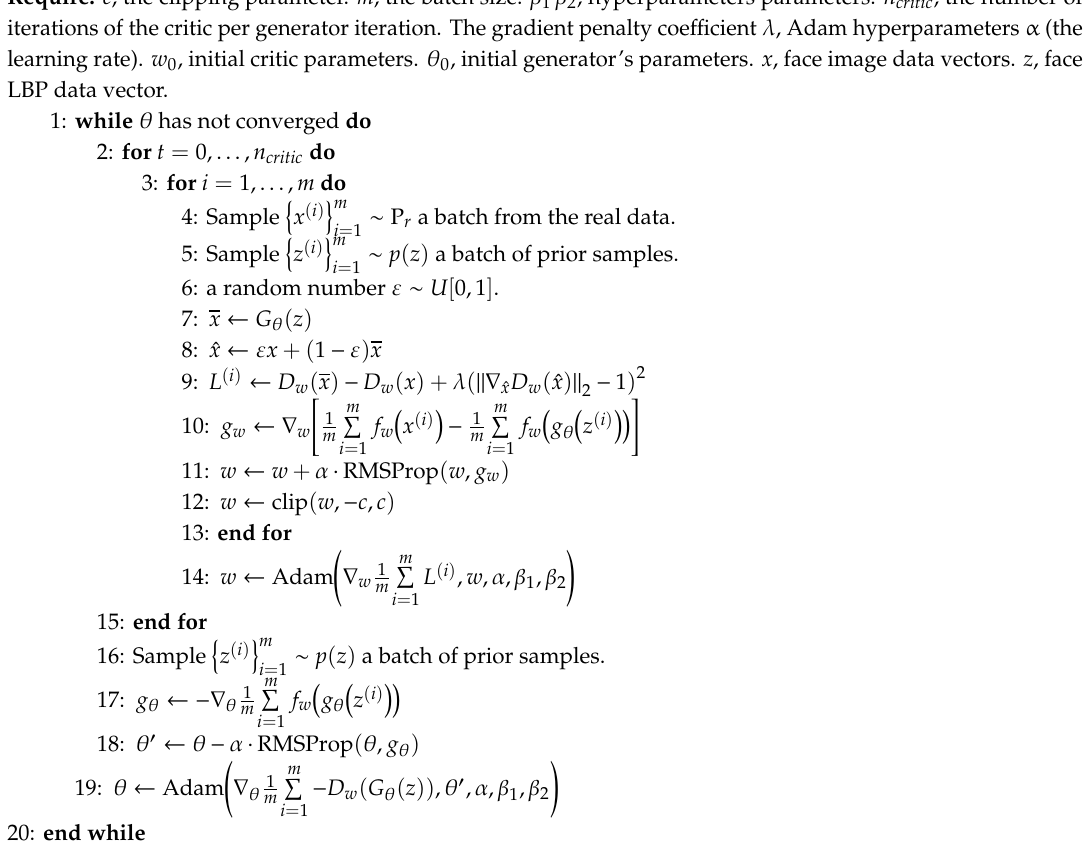
Algorithm 1 WGAN-E, a neural cryptography algorithm. All experiments in the study used default values α = 0.001, c = 0.04, m = 2000, n